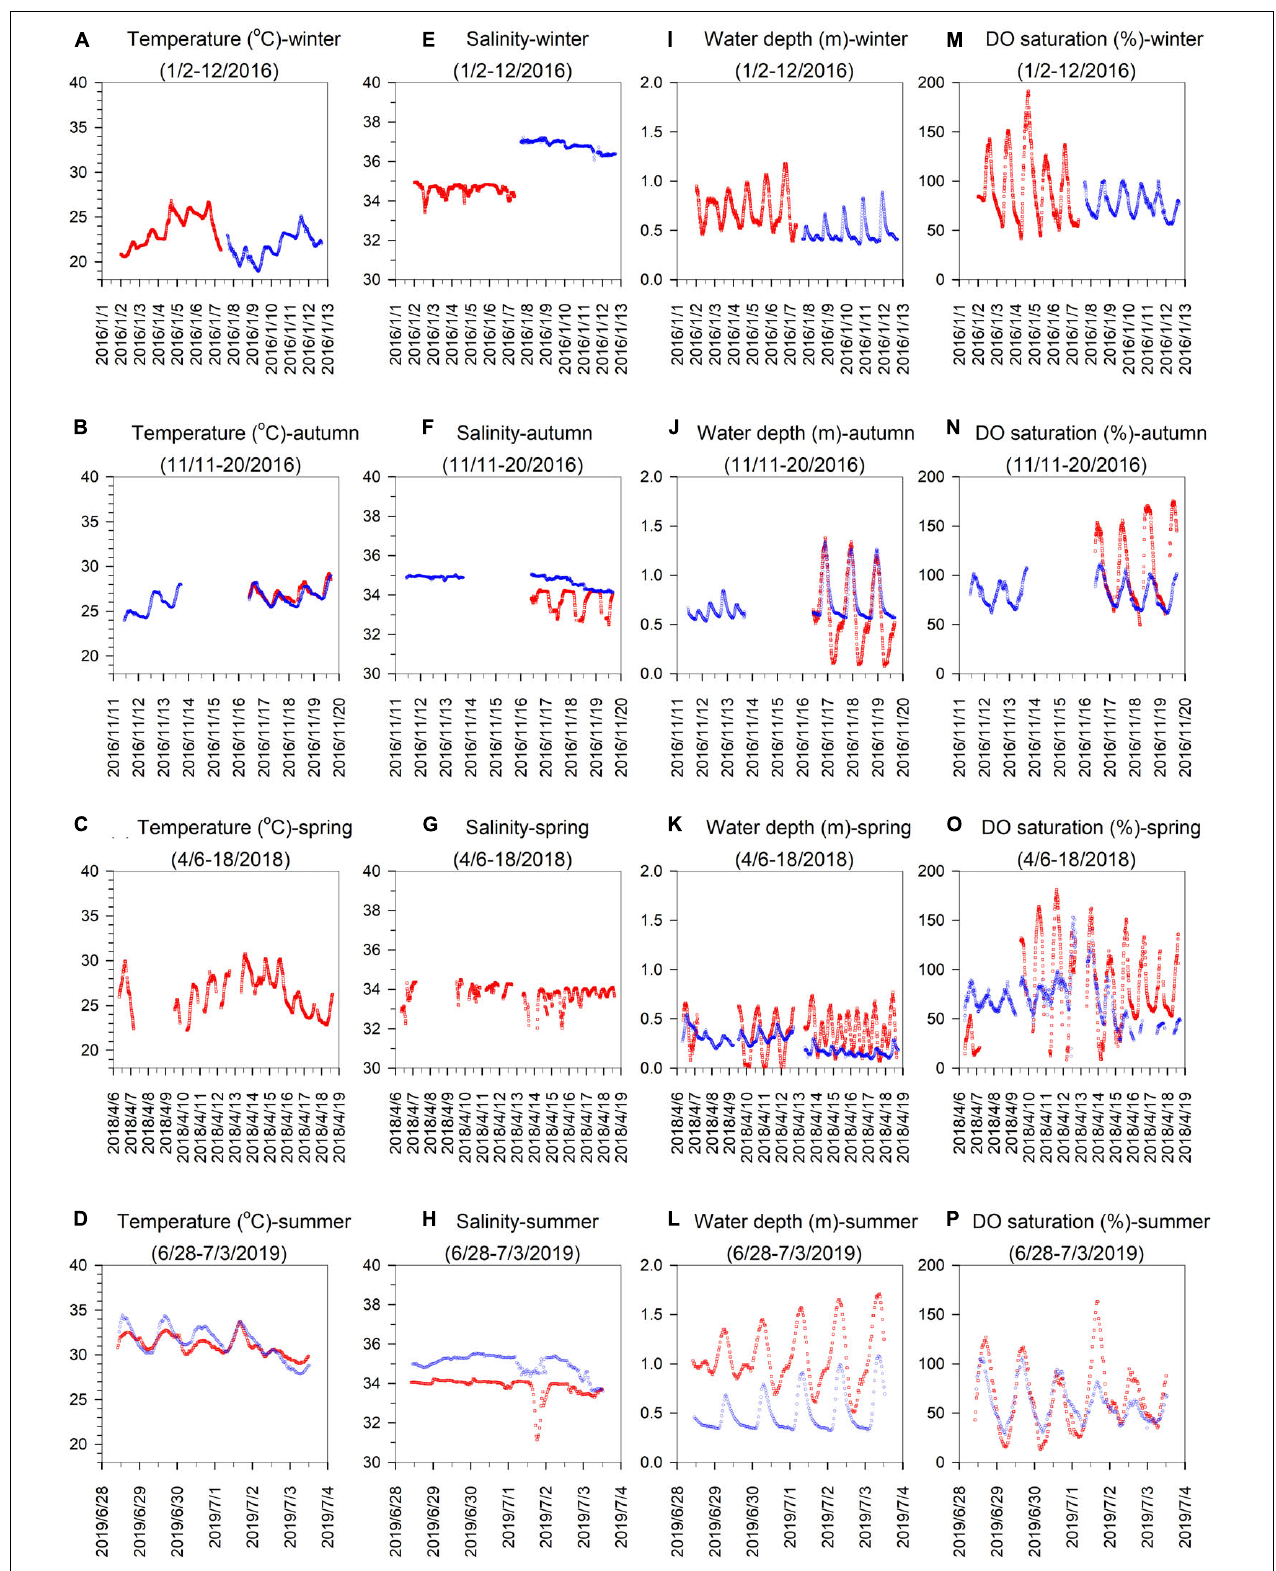
FIGURE 2 | Seasonal time-series observations of (A–D) temperature, (E–H) salinity, (I–L) water depth, and (M–P) DO saturation in the inner lagoon (IL, blue circles) and on the northern shore (NS, red squares) of Dongsha Island.